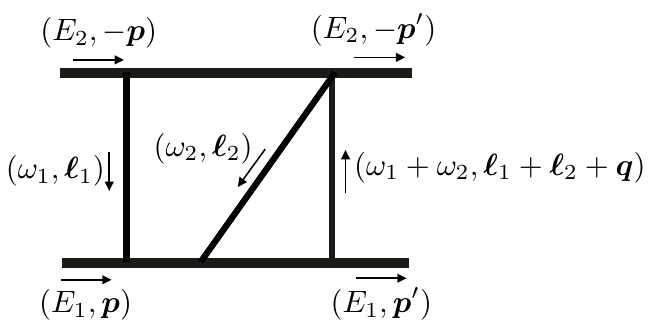
Figure 22 . The box-triangle